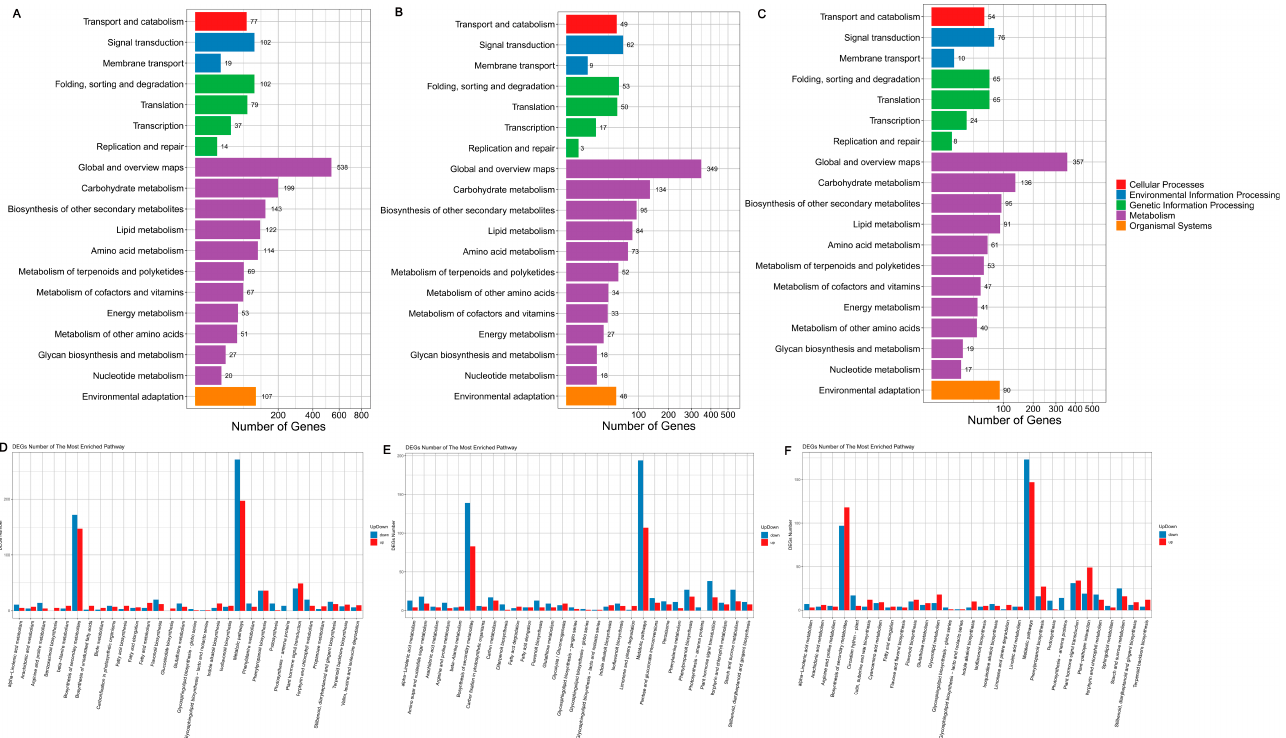
Figure 4. KEGG pathway classification of differentially expressed genes (DEGs) in groups 22 DAP vs. 14 DAP. KEGG plots of groups 22-22 vs. 22-14 ( A ), 30-22 vs. 30-14 ( B ), and QPCQ-22 vs. QPCQ-14 ( C ). Top 30 pathways and up-/downregulated DEGs in these pathways in groups 22-22 vs. 22-14 ( D ), 30-22 vs. 30-14 ( E ), and QPCQ-22 vs. QPCQ-14 ( F ).